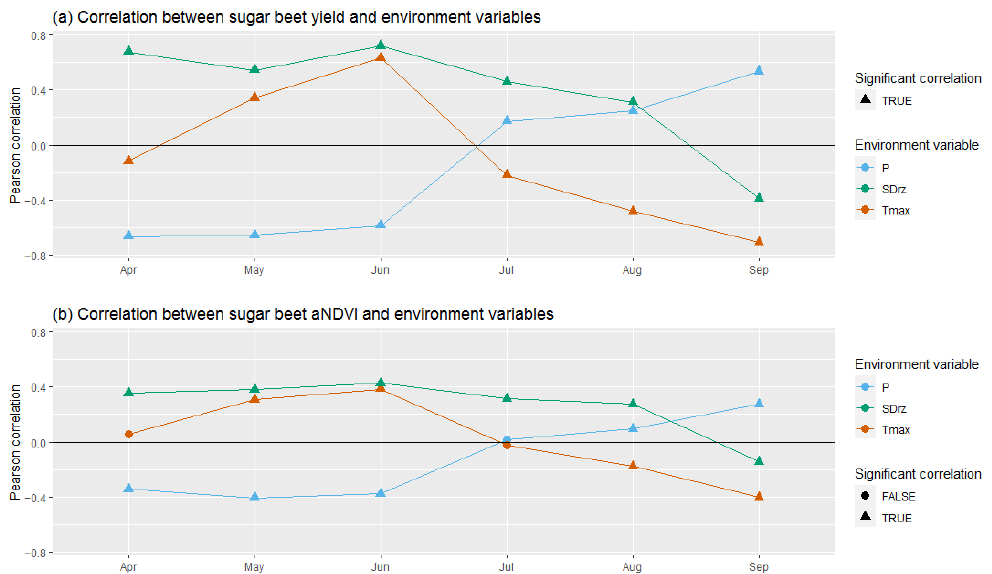
Figure 7. Pearson correlations for sugar beet during April–September between ( a ) yield and monthly precipitation (P), maximum temperature (Tmax), and root-zone soil water depletion (SDrz), ( b ) aNDVI and monthly precipitation (P), maximum temperature (Tmax), and root-zone soil water depletion (SDrz). Significant correlation values ( p < 0.01) are indicated with a triangle and nonsignificant correlation values ( p > 0.01) with a circle.